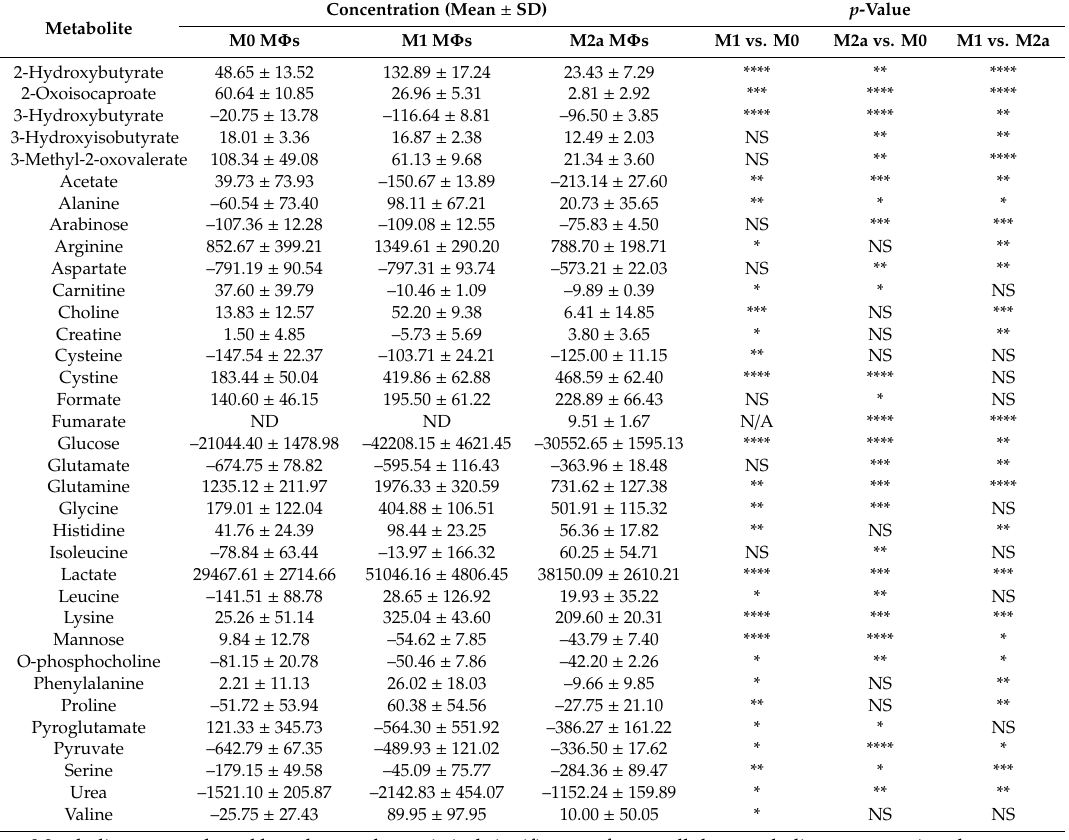
Table 2. Discriminatory metabolites in extracellular extracts associated with